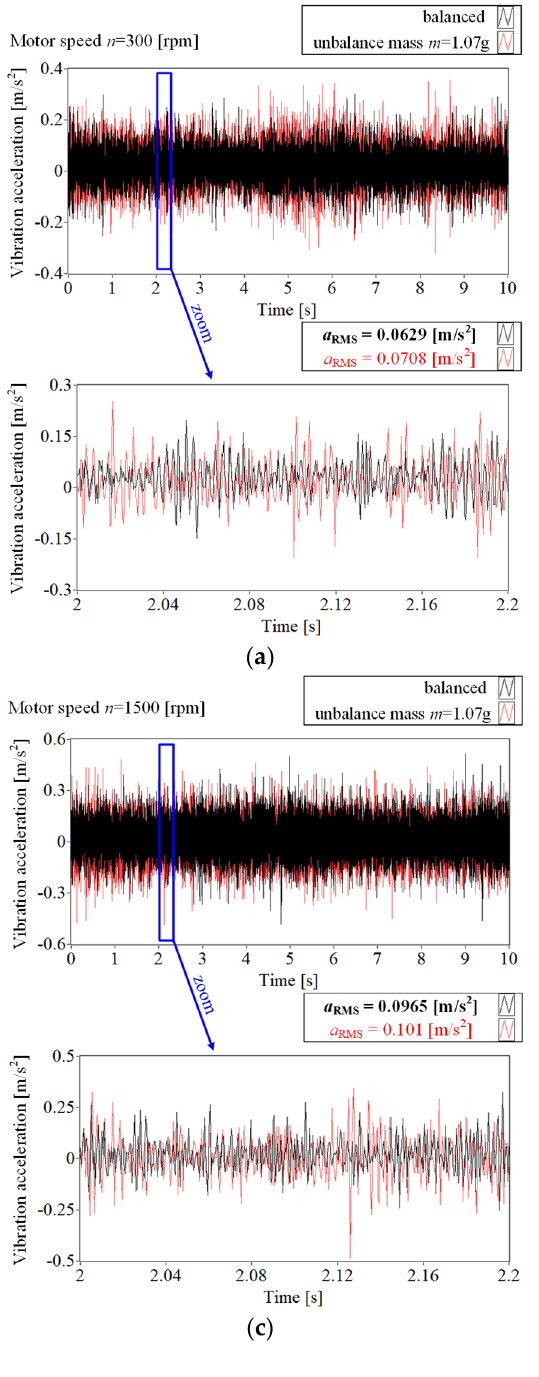
Figure 6. Samples of experimental measurements of mechanical vibrations for tested the PMSM drive at different motor speeds and unbalance masses: ( a , c ) m 1 = 1.07 g; ( b , d ) m 5 = 2.36 g; ( a , b ) n = 300 rpm; ( c , d ) n = 1500 rpm.